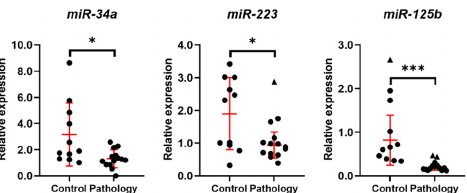
Figure 4. Expression of miRNA related to regulation of genes of reproduction system cells. Results are presented as mean ± standard deviation (red lines); triangle data points represent outliers based on ROUT (Q = 5%). In the control group, n = 11; in the pathology group, n = 14. * p ≤ 0.05; *** p ≤ 0.001, based on the Mann–Whitney U test.